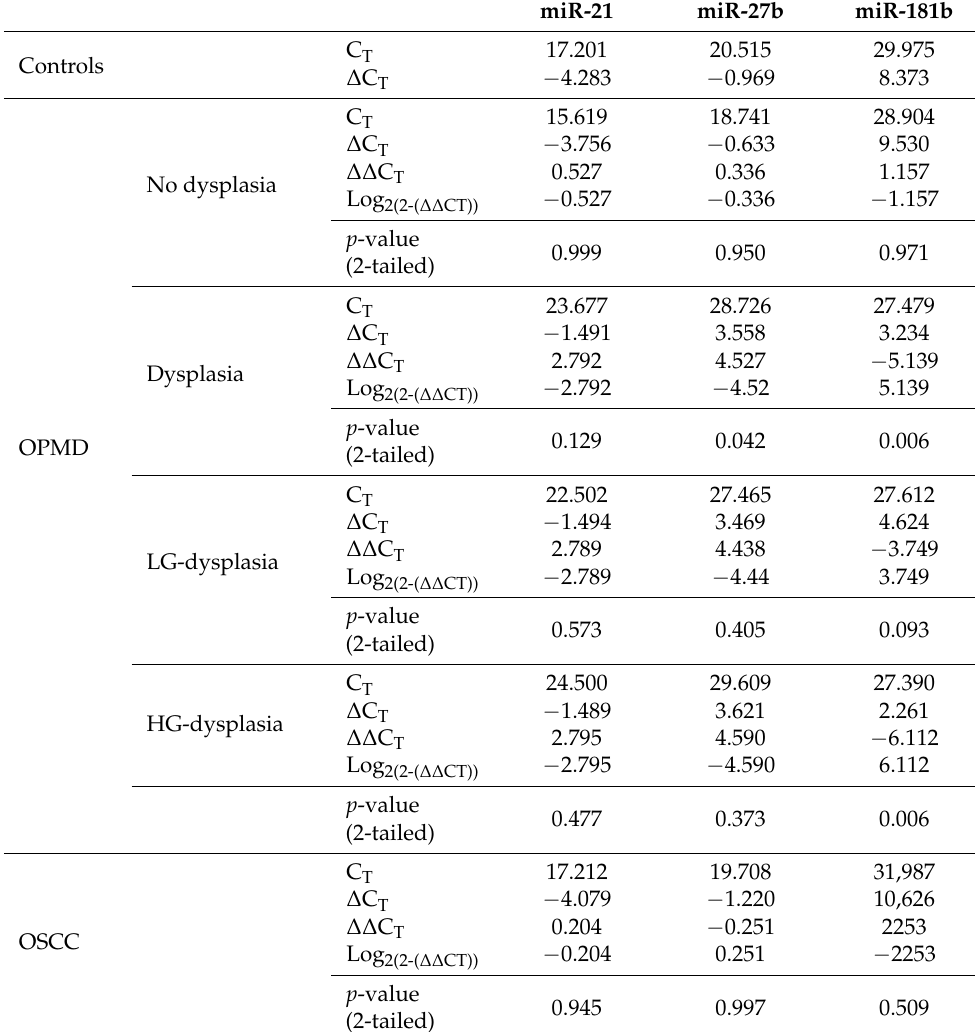
Table 2. miRNAs expression in the analyzed groups. The significance values refer to the comparison of the mean of each group and subgroup with the control